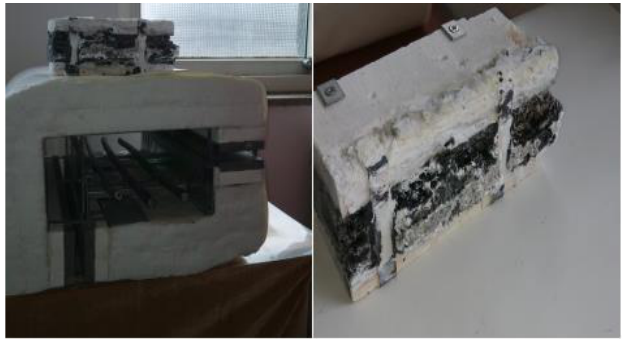
Figure 1. Ceramifiable IFR protector and the IFR protection effect. The expansion and ceramization mechanisms of CSR for retarding flame are illus- trated in Figure 2. An active flame-retardant effect can be achieved through effective con- trol of the expansion temperature and the extent of expansion.